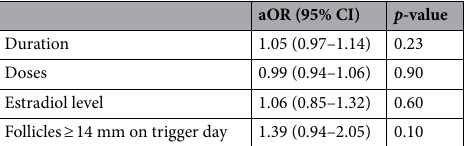
Table 4. Multivariate logistic regression for MP (twin and higher order multiple pregnancies) (multivariate GEE model).